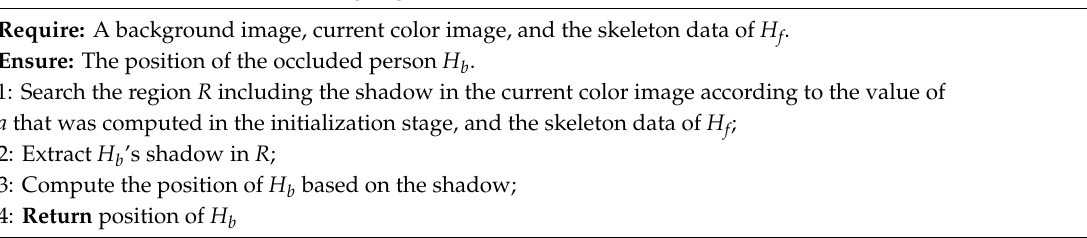
Algorithm 1 Shadow-based Tracking